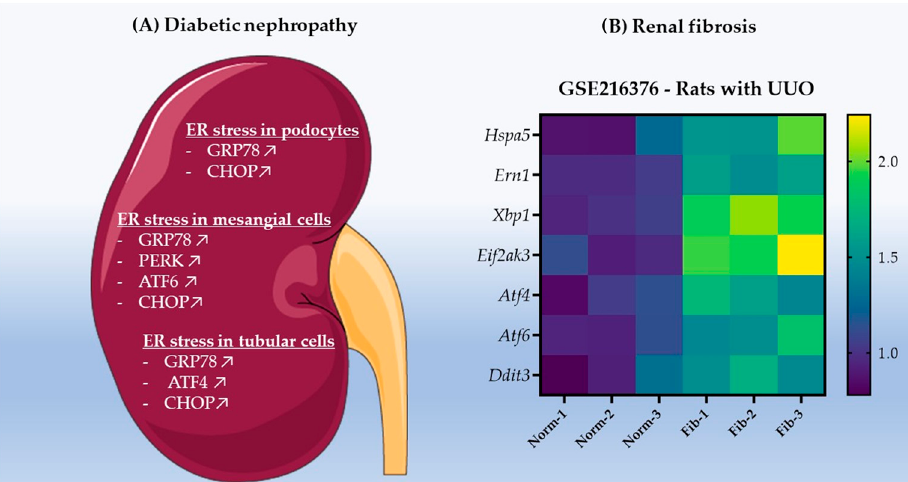
Figure 2. ER stress activation in diabetic nephropathy and renal fibrosis. ( A ) Schematic representation of the different UPR mediators upregulated in podocytes [79,80], mesangial cells [81–83] and tubular cells [84–86] in diabetic nephropathy. The illustration was designed using images from the Servier Medical art database (smart.servier.com). ( B ) Heatmap representation of the expression of Hspa5 (encoding GRP78), Ern1 (encoding IRE1 α ), Xbp1 , Eif2ak3 (encoding PERK), Atf4 , Atf6 and Ddit3 (encoding CHOP) in the kidneys of normal adult rats that underwent sham surgery ( n = 3; Norm) and adult rats that underwent unilateral ureter obstruction (UUO) ( n = 3; Fib) in order to induce renal fibrosis development. The data were acquired from the GEOdataset GSE216376 (https://www.ncbi.nlm.nih.gov/geo/query/acc.cgi?acc=GSE216376 accessed on 26 December 2022–expression profiling by high throughput sequencing). Graphical representation of the fold-change to control group was designed with the GraphPad Prism 9